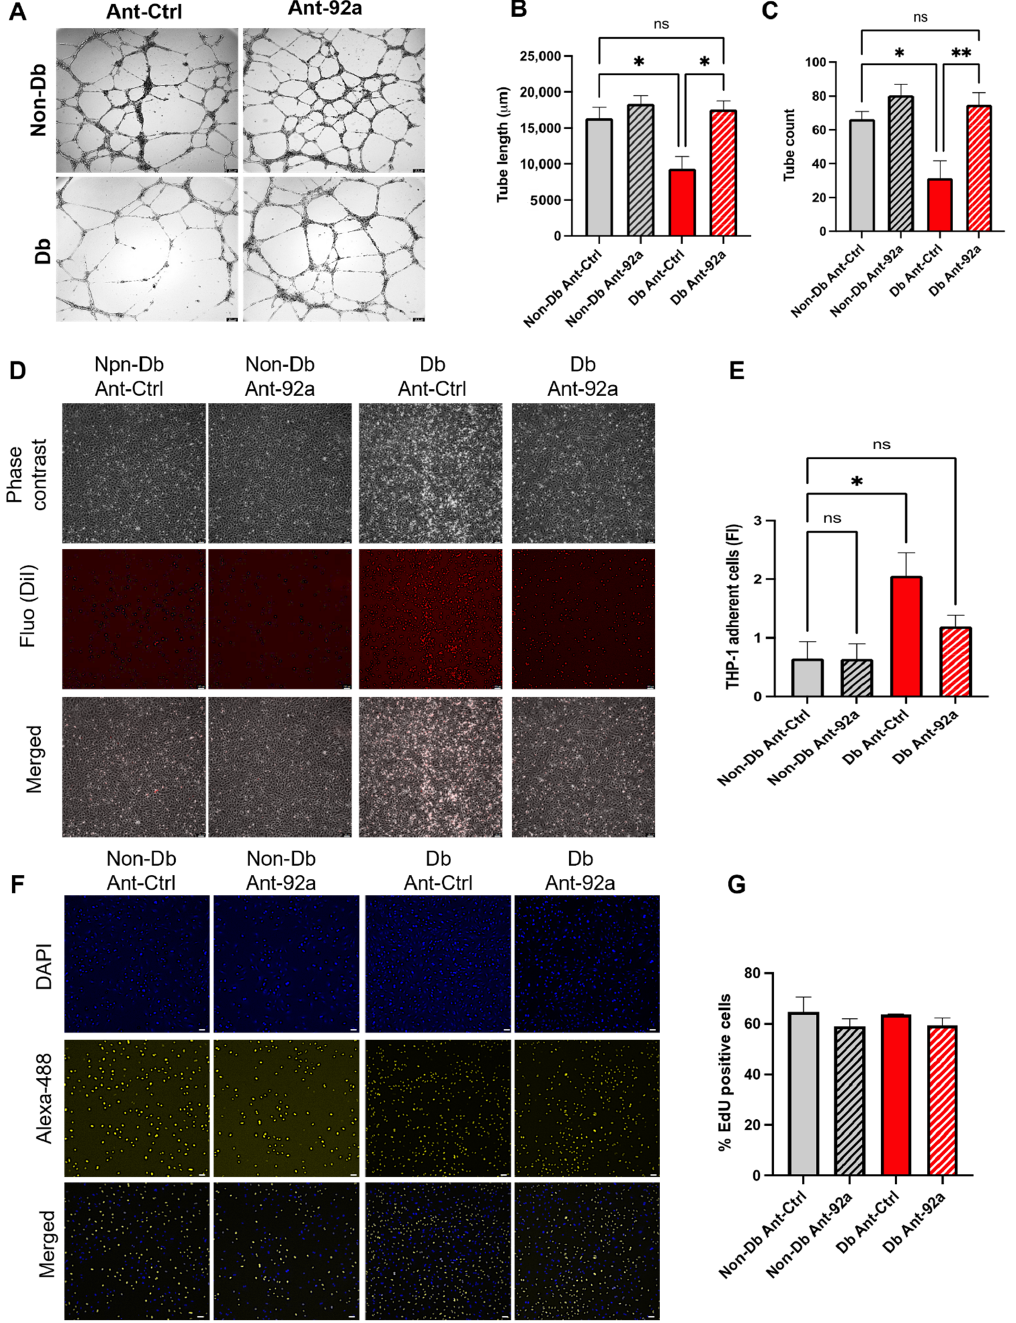
Figure 3. Inhibition of miR-92a rescues diabetic phenotype in HCMEC. ( A – C ) Bright field images and analysis of tube formation parameteres in Db or Non-Db HCMEC upon downregulation of miR-92a (Ant-92a) or control (Ant-Ctrl). ( D , E ) Phase contrast images, fluorescence images and anal- ysis (fold change) of adherent THP-1 (DiI-labeled) count on Db or Non-Db HCMEC monolayer upon downregulation of miR-92a (Ant-92a) or control (Ant-Ctrl). ( F , G ) Fluorescence images and